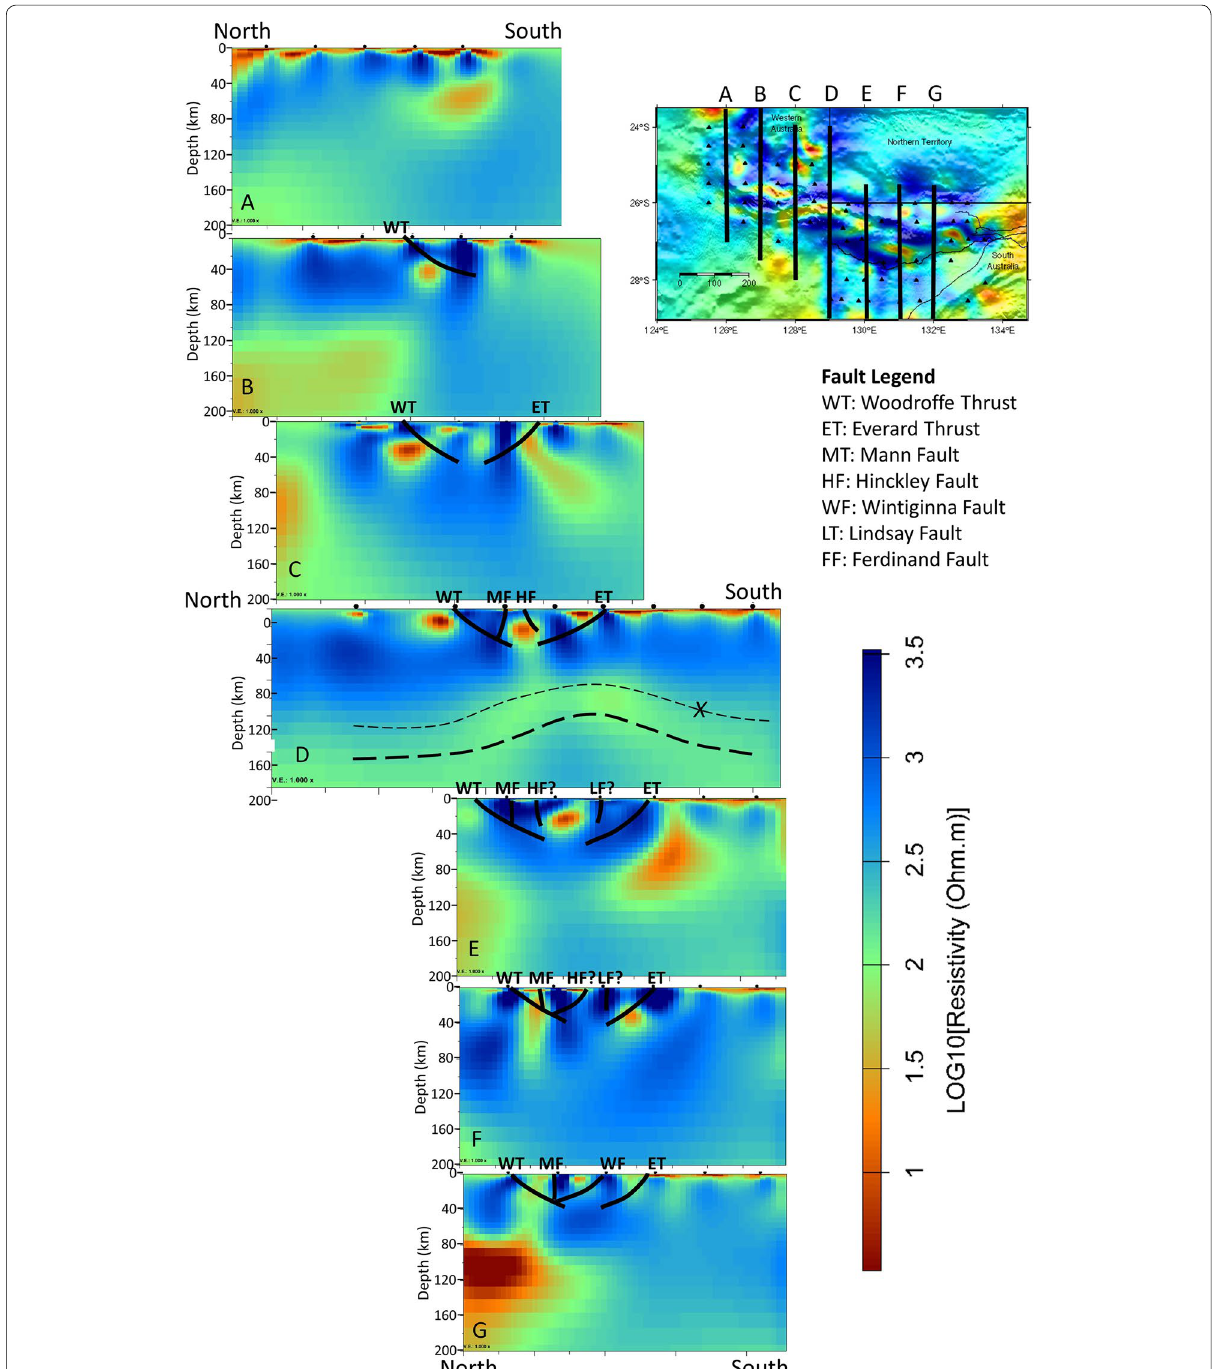
Fig. 9 Composite of seven north–south cross-sections through the preferred 3D inverse model of the Musgrave Province. The inferred position of a number of the Musgrave Province’s main faults, imaged by the MT survey, is identified and labelled. In particular, the Woodroffe Thrust and the Mann Fault are shown as well as the inferred position of the Mundrabilla Shear Zone (Aitken et al. 2016). The surface ’X’ is interpreted to suggest offsets in the upper mantle. The Western Australia, Northern Territory and South Australia state boundaries are plotted on the inset map for location